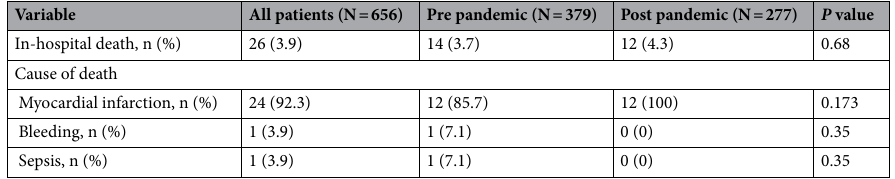
Table 3. Clinical outcomes. Values are presented as number of patients